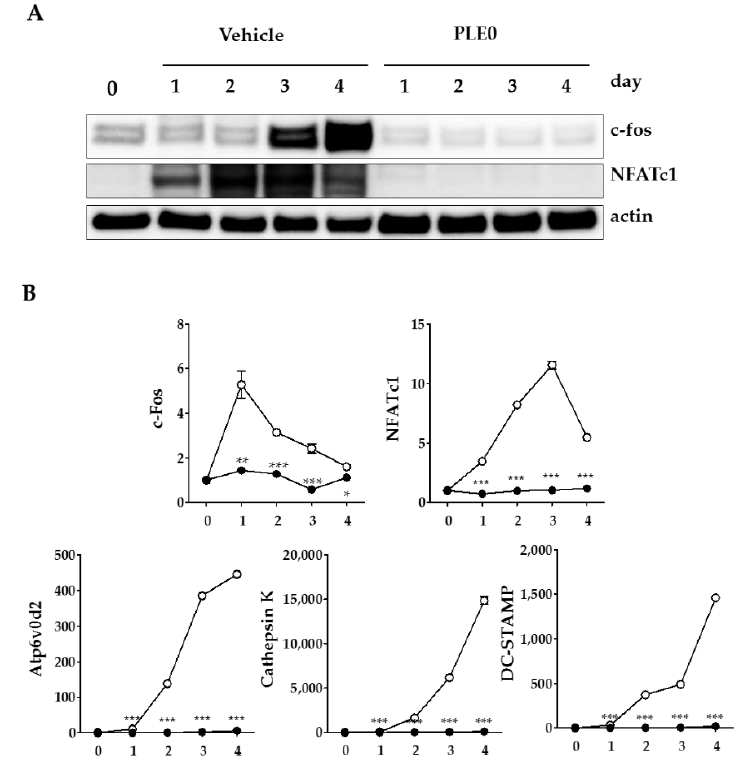
Figure 4. Inhibitory effect PLE0 on RANKL-induced expression of c-Fos and NFATc1 in BMMs. ( A ,